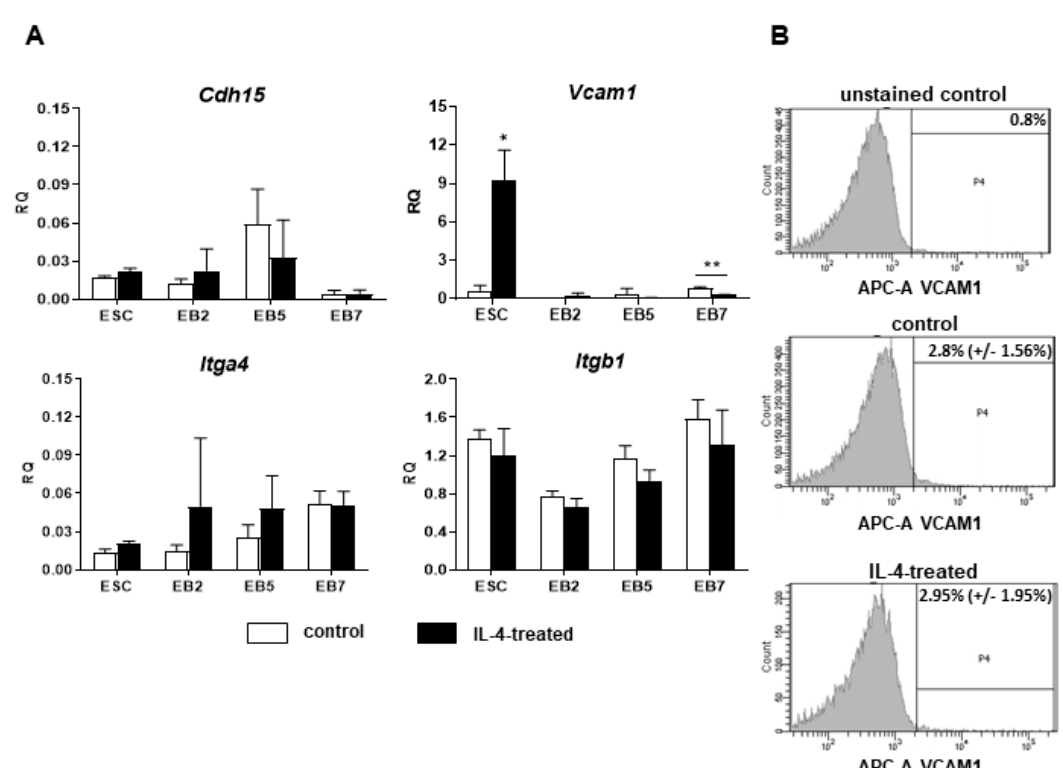
Figure 4. Analysis of IL-4 influence on expression of selected cell membrane proteins in ESCs. ( A ) Expression of Cdh15 , Vcam1 , Itga4, and Itgb1 in undifferentiated and differentiating ESCs cultured with or without exogenous IL-4. β -actin was used as a reference gene. RQ = 1 for the expression level detected in 13.5-day-old mouse embryo. Data are presented as means of three independent experiments with standard deviations; * p < 0.05; ** p < 0.01. ( B ) Representative histograms presenting percentage of cells synthesizing VCAM1 in unstained control (upper), control (middle), or IL-4-treated (bottom) ESCs after 2 days of treatment, analyzed with flow cytometry.